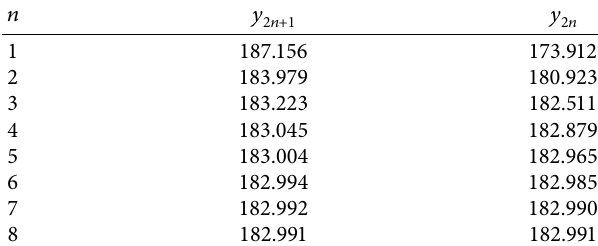
Table 1: Sequence solution for the optimal normal